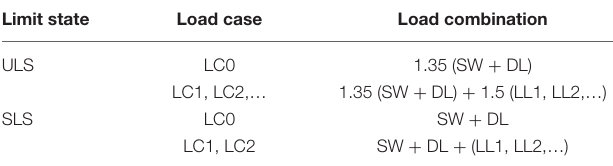
TABLE 4 | Load combination